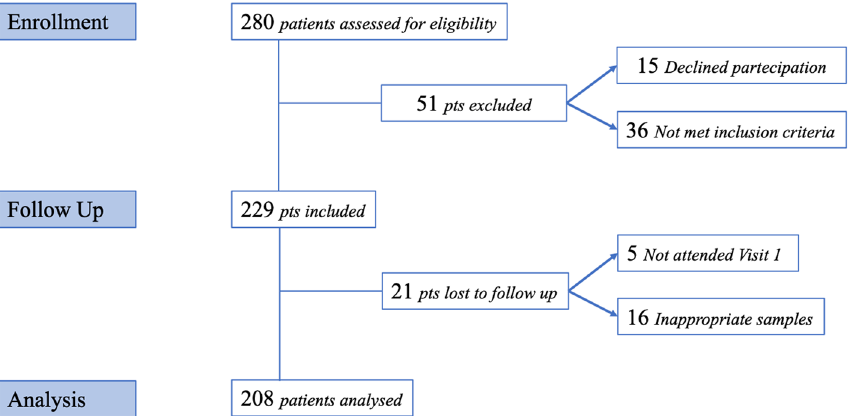
Figure 1. Study flow-chart.